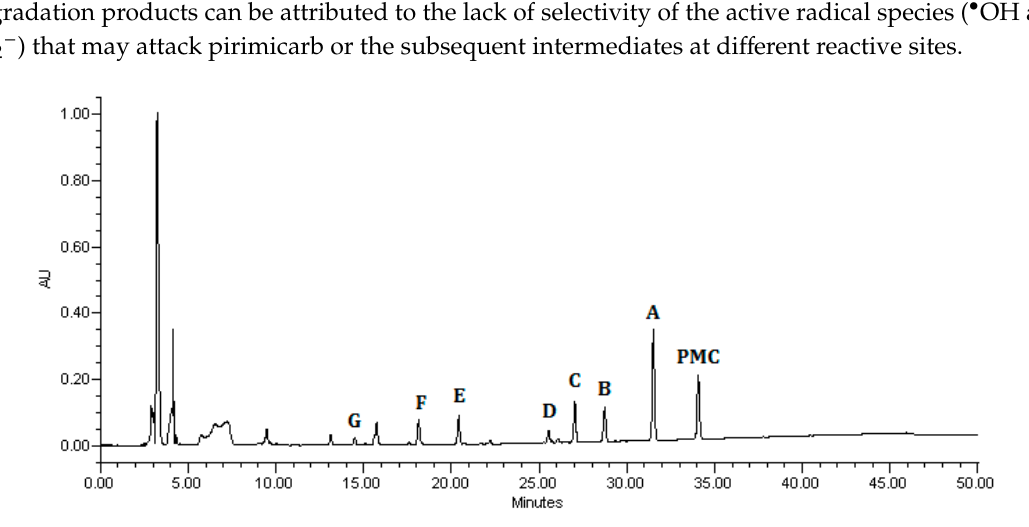
Figure 13. HPLC chromatogram obtained for pirimicarb solution (10 mg L − 1 ) after 16 h of irradiation with visible light in the presence of 1.0 wt% Pt / AgInS 2 catalyst (1.0 g L − 1